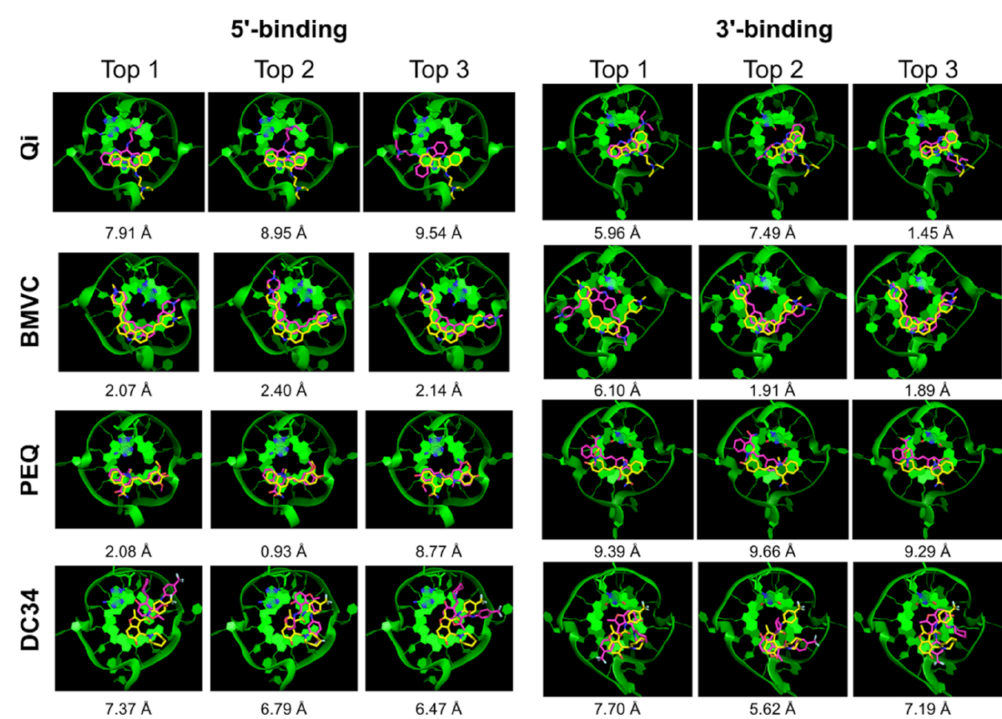
Figure 6. RxDock top 3 docked poses (purple) superimposed onto the NMR poses (yellow). The G4 DNA is shown as green ribbon.